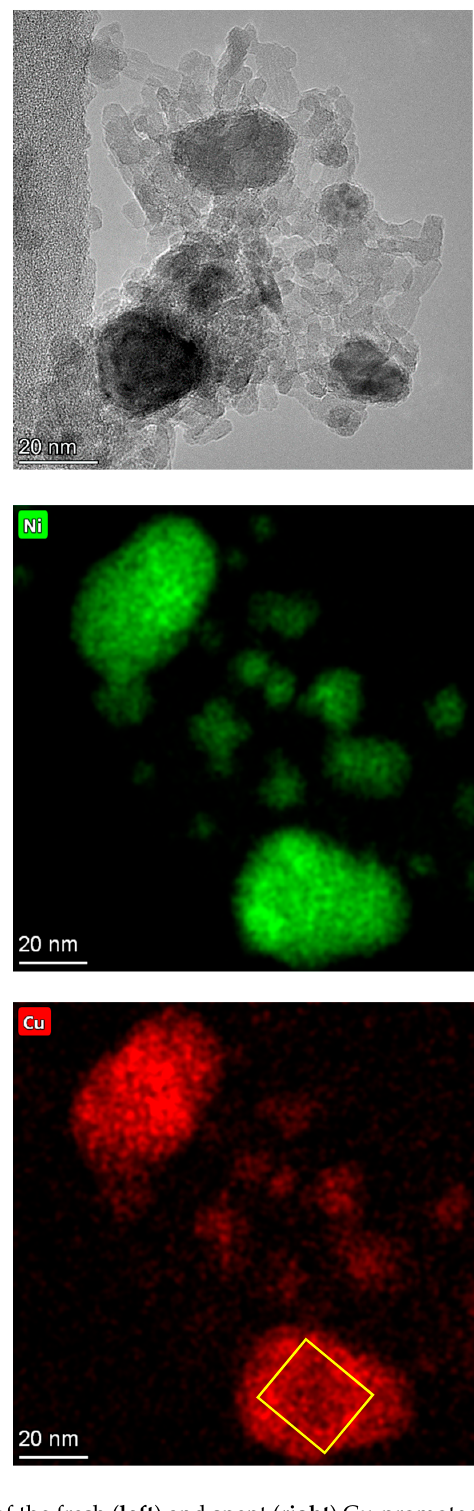
Figure A9. TEM micrographs and elemental maps of the fresh ( left ) and spent ( right ) Cu-promoted catalysts showing both the formation of large particles during catalyst aging and the close association of Ni and Cu irrespective of the catalyst state (fresh or spent). Note that micrographs and elemental maps correspond to different regions. The yellow box on the bottom right micrograph denotes the Cu-hollow space.